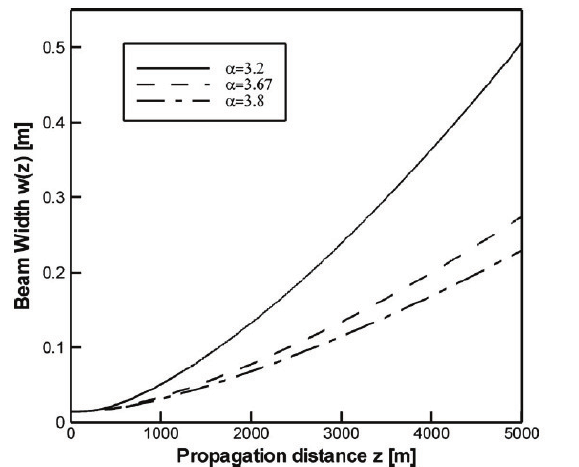
Figure 13. The root-mean-square width of a scalar Gaussian–Schell model (GSM) beam on propaga- tion in non-Kolmogorov turbulence. Reprinted with permission from Reference